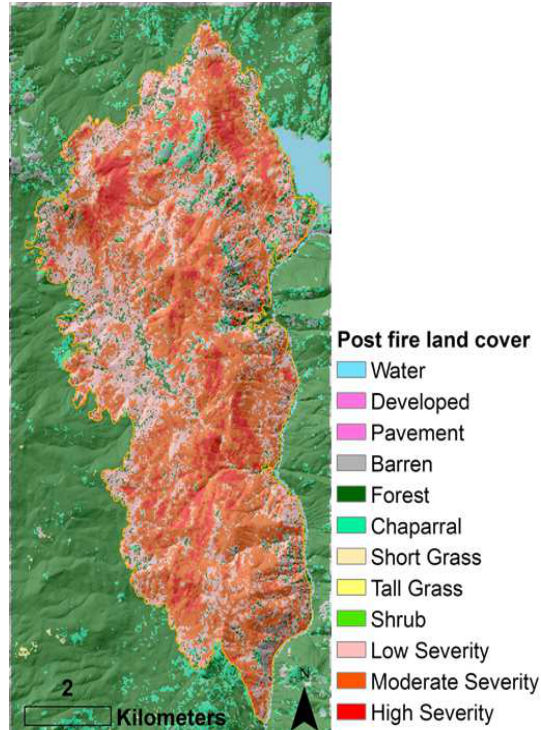
Figure 3. Example post-fire land cover map generated by the database for the French Fire.